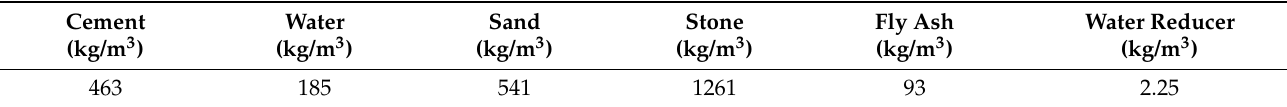
Table 3. Mixing proportions of the concrete